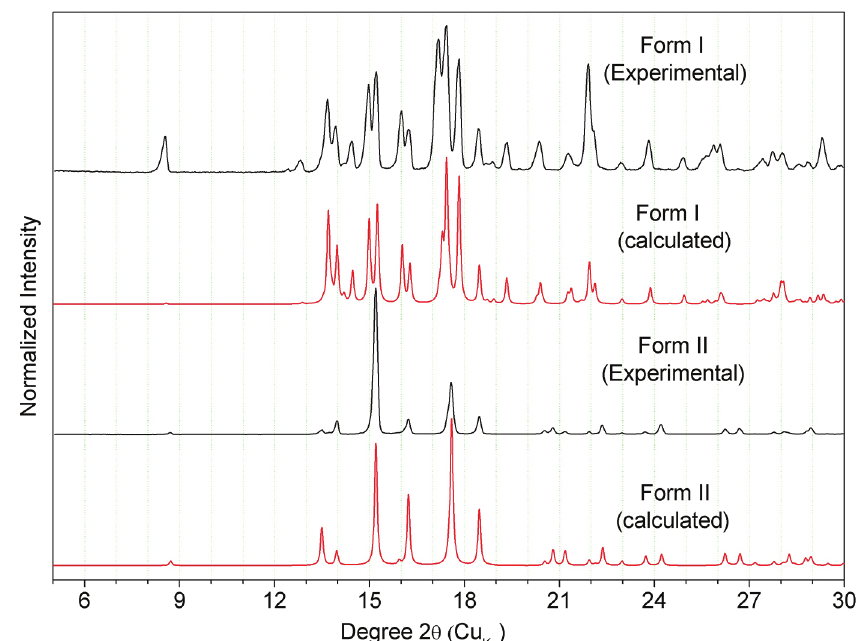
FIGURE 2 - Calculated (Declercq, Van Meerssche, Zeelen 1984; Schouten, Kanters, 1991) and experimental PXRD pattern of forms I and II of tibolone. )) from simulated patterns of tibolone forms I and II in comparison with TABLE I - X-ray diffraction peaks (Positions in 2 q (Cu K a the experimental PXRD diffractograms of samples obtained from the recrystallization procedures Form I (Calculated) (Declercq, Van